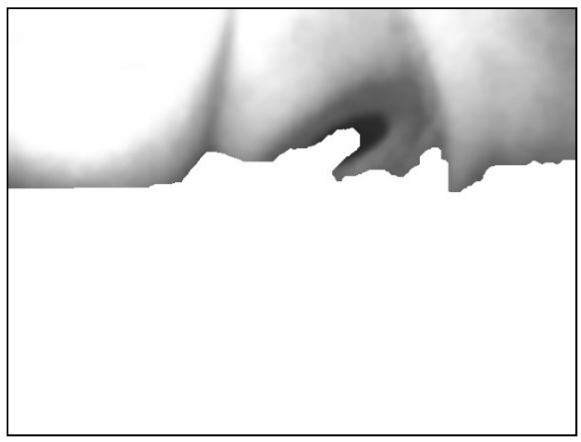
Figure 26. Image of connected pupil block.